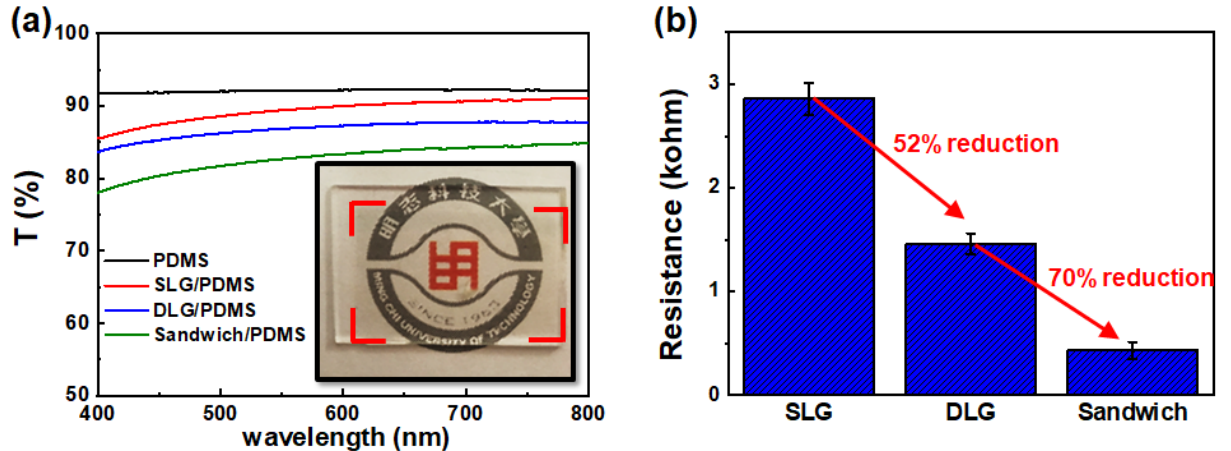
Figure 3. ( a ) UV-Vis spectrum of pristine PDMS, SLG/PDMS, DLG/PDMS and sandwich/PDMS. ( b ) Resistances of SLG, DLG, and sandwich.